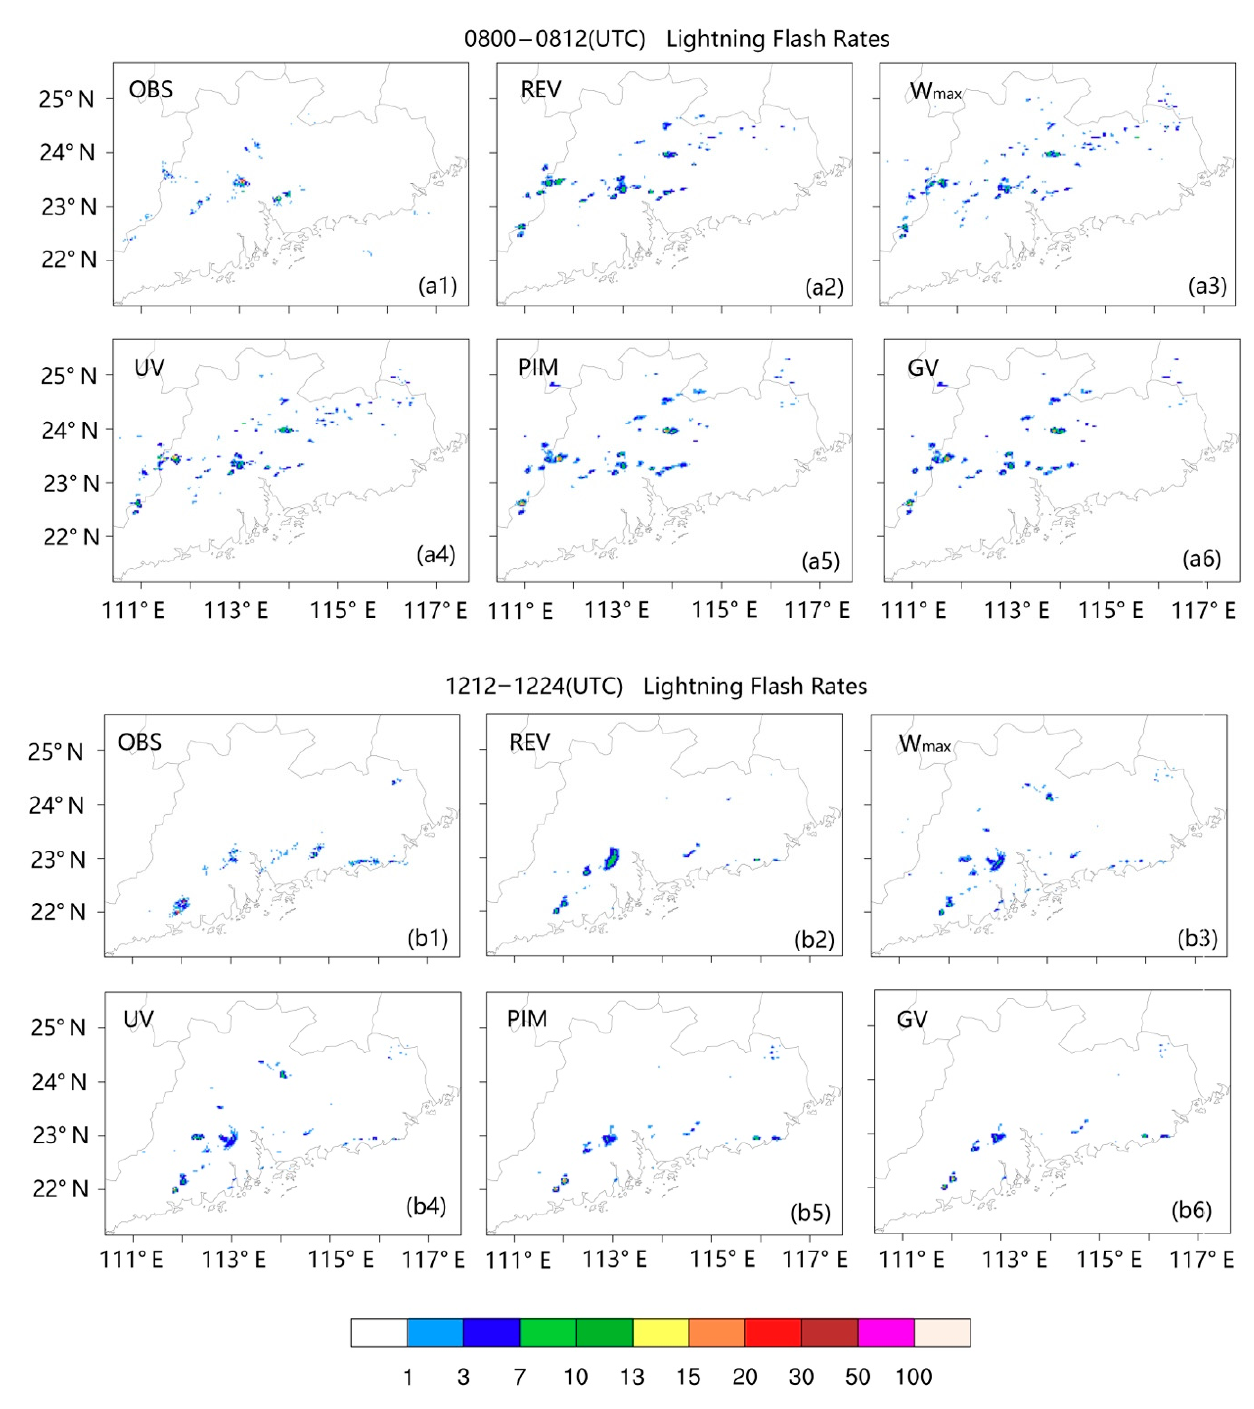
Figure 4. The total lightning flash rates (at 9 km 2 ) accumulated over two 12 min periods. ( a1 , b1 ) are from the observations, and ( a2 – a6 ), ( b2 – b6 ) are from the different lightning diagnostic schemes with different proxies. The abbreviations of each lightning diagnostic scheme are labeled in each panel.